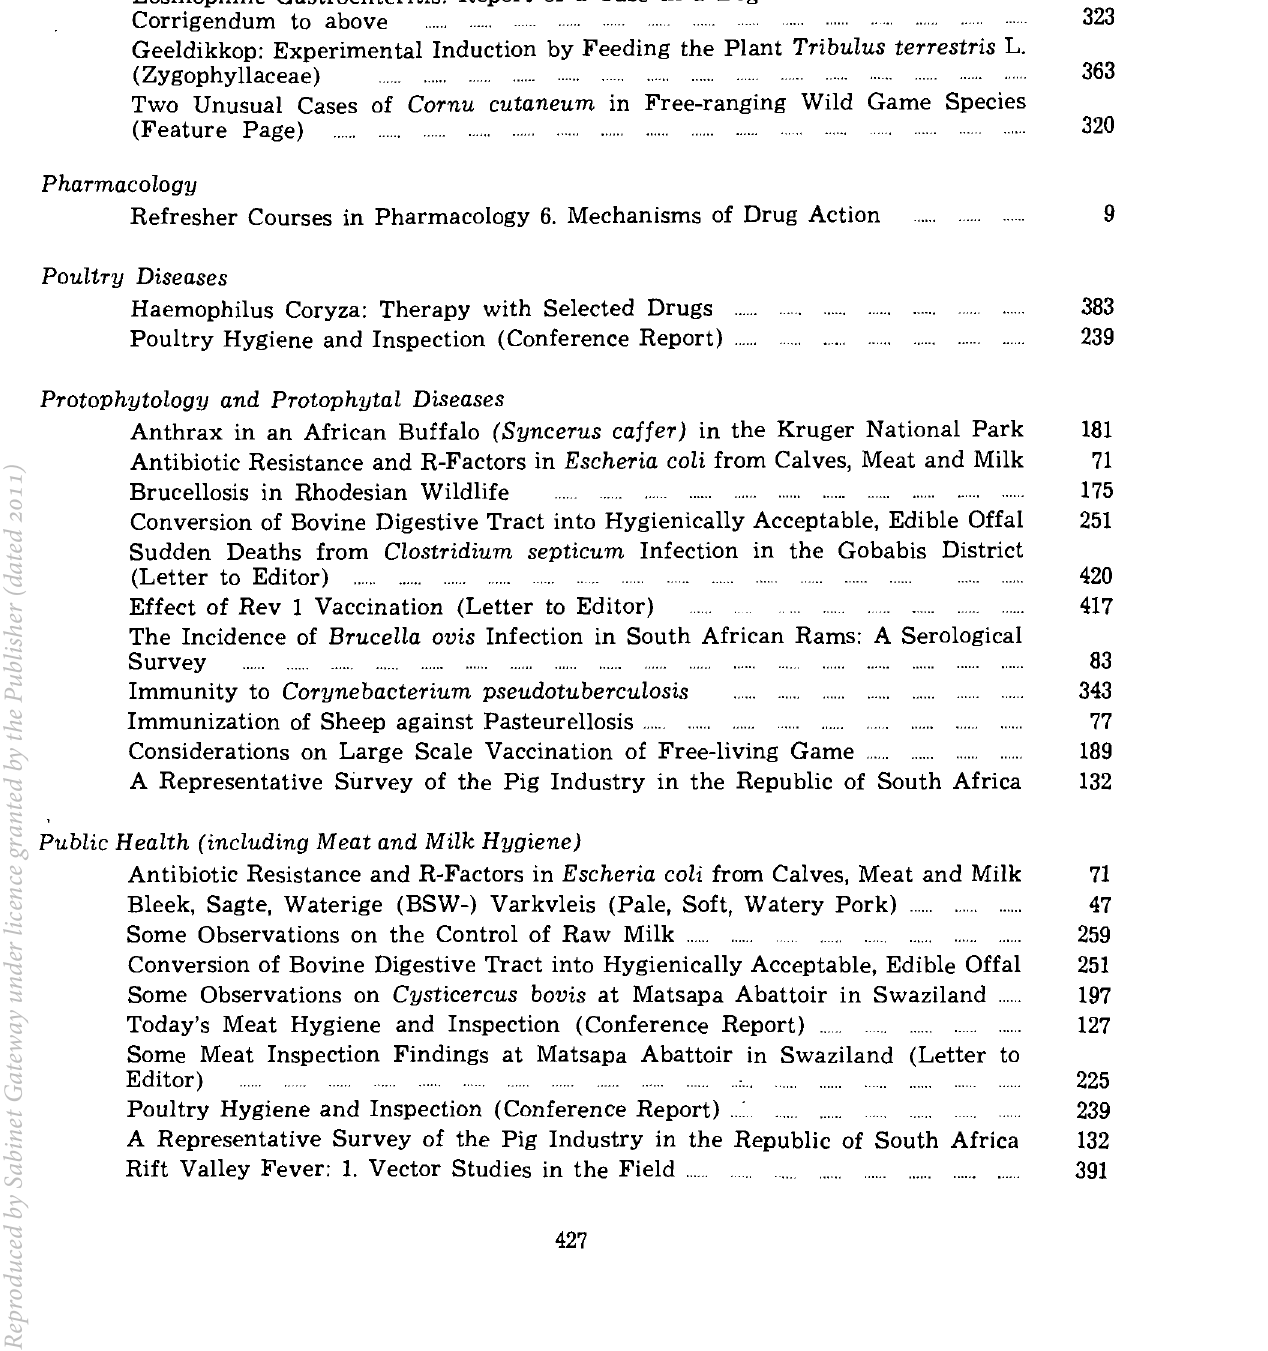
Drought and Supplementary Feeding of Sheep in the Karoo